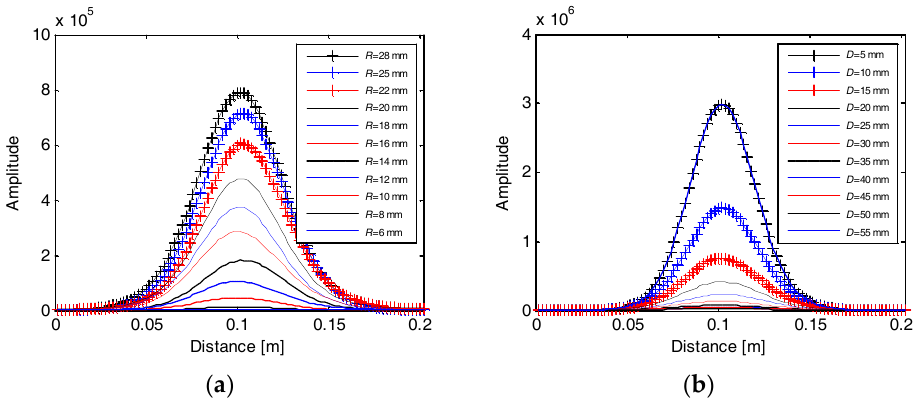
Figure 4. Recoded EMI curves in the calibration experiment when ( a ) D = 20 mm and ( b ) R = 20 mm . D and R are the cover thickness and diameter of the rebars, respectively.